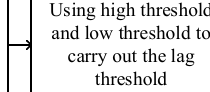
Figure 7. Improved block diagram of edge detection algorithm.